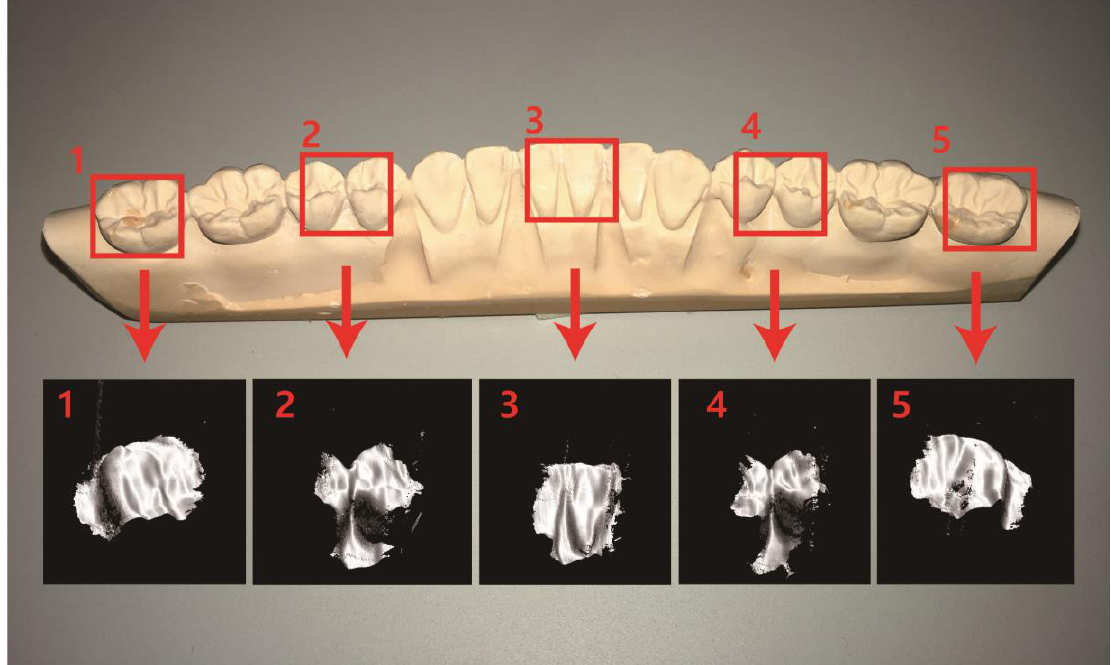
Figure 5. The dental cast and the 3D point cloud models of the dental cast from different scanning points. The sectioned images were combined in a single volume to show different areas of the dental cast.